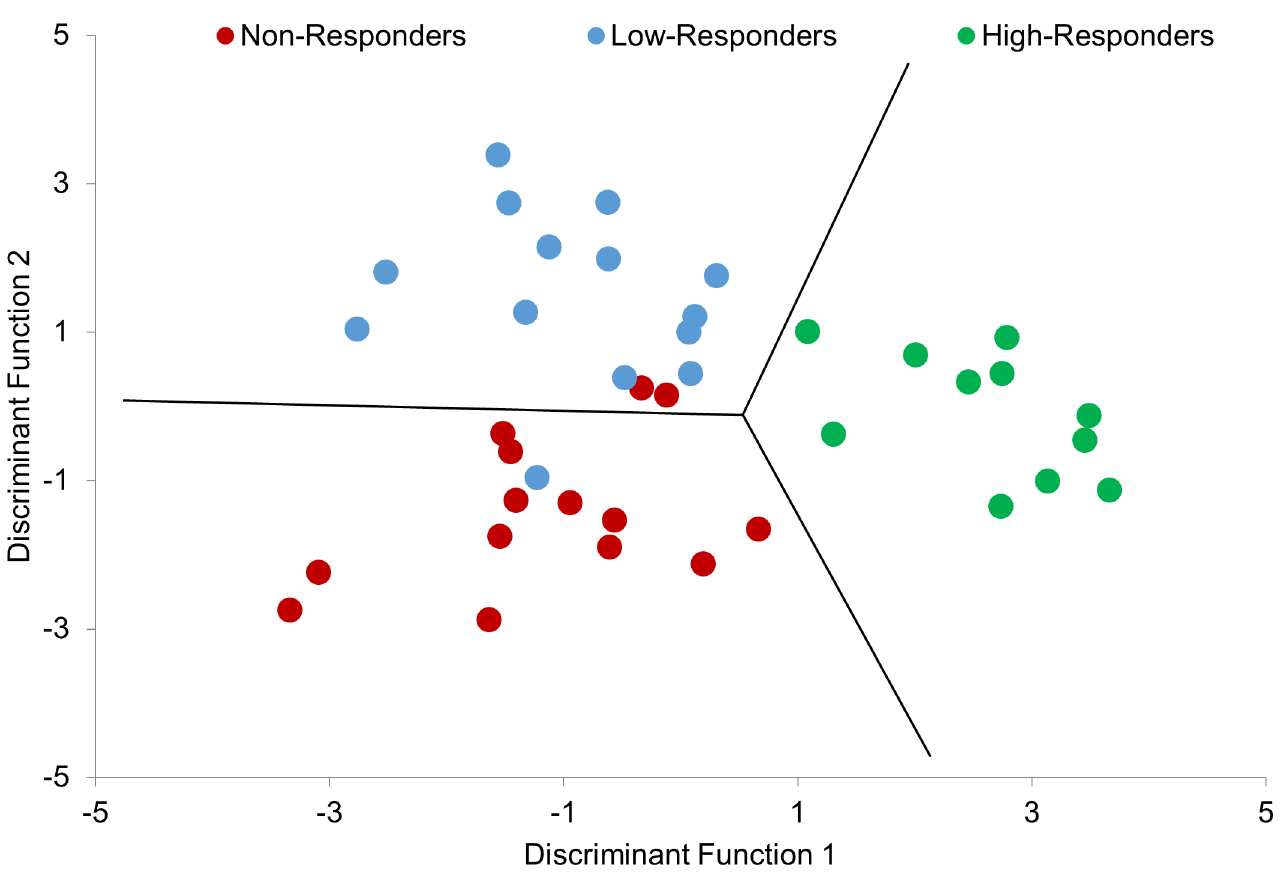
Fig 4. Scatterplot of discriminant function scores computed from pre-intervention patient-reported outcome measure (ADL) and gait of knee OA responder subgroups.